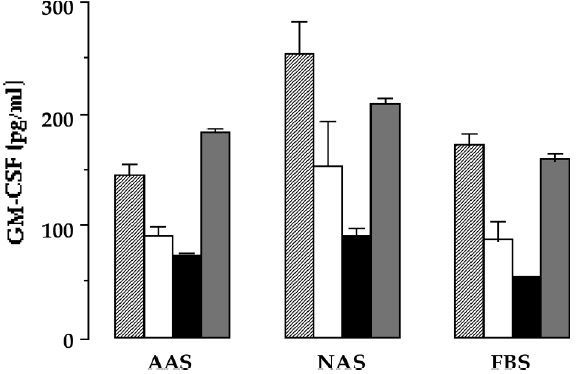
FIG. 3. IL–1 b and TNF- a induced GM-CSF release in human airway smooth muscle cells plated at 1 ´ 10 4 (striped bars), 3 ´ 10 4 (white bars), 9 ´ 10 4 (black bars) or 2.7 ´ 10 5 (grey bars) cells/well in either allergic asthmatic serum (AAS), non- allergic non-asthmatic serum (NAS), or foetal bovine serum (FBS). Cells were serum starved for 24h prior to stimulation with IL–1 b and TNF- a (10ng/ml) for 24h (Table 1: protocol 2). Bars represent means±SD from triplicate wells of one cell